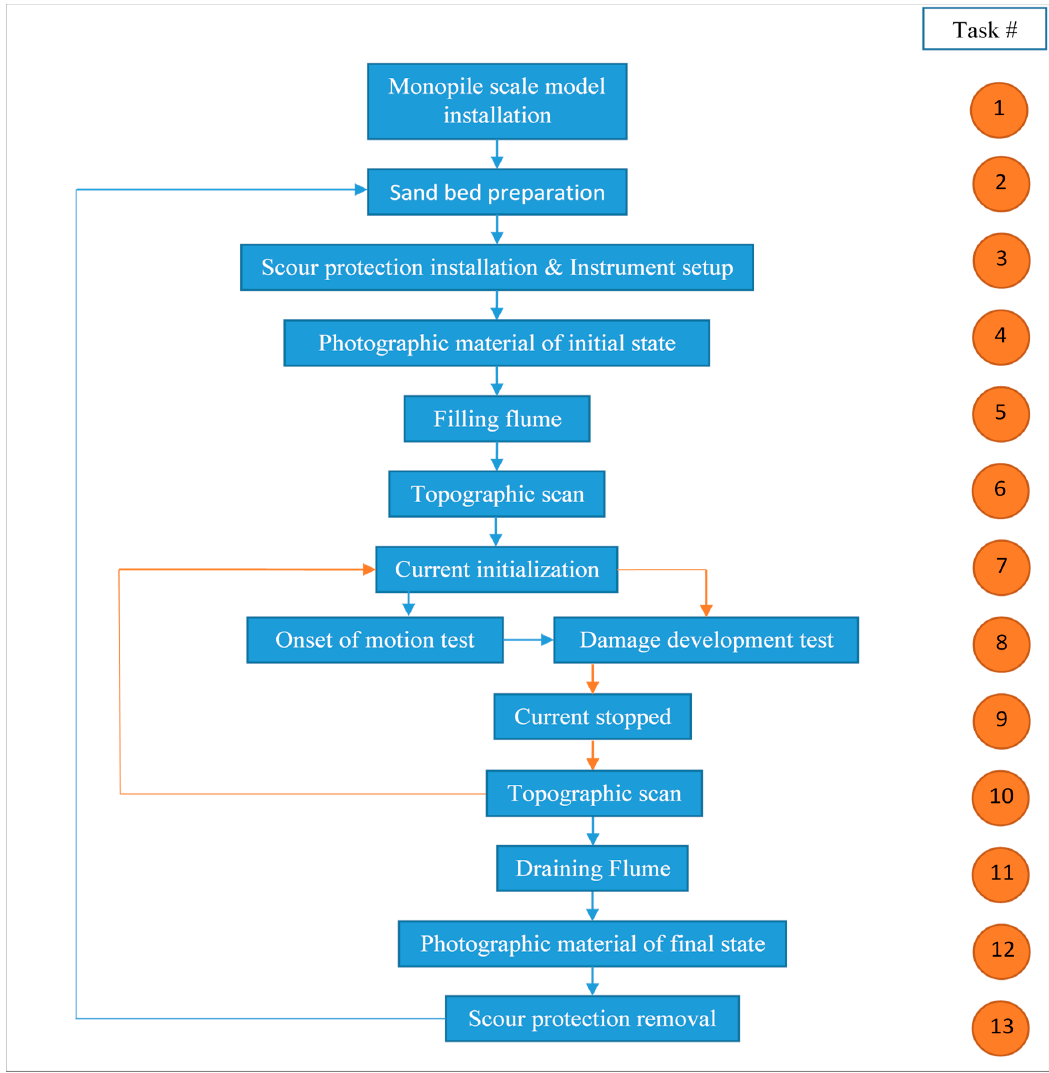
Figure 5. Flow chart of experiment execution. The loop indicated using orange arrows is performed three times for Test No. 14 and twice for the other damage development tests.